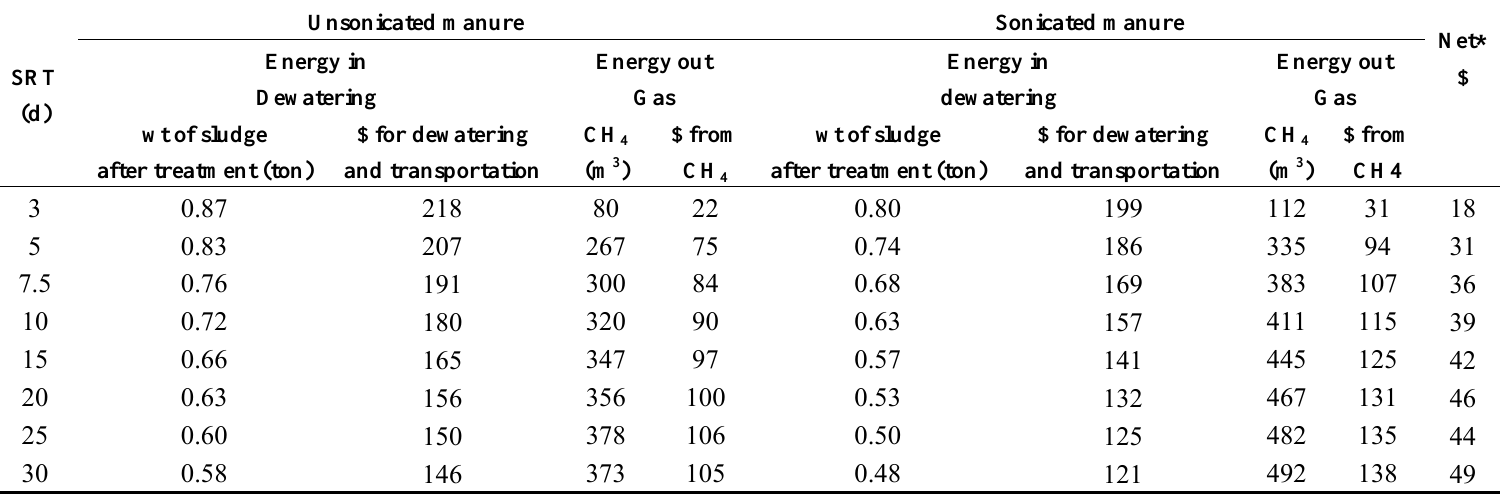
Table 4. Economical study calculation based on ton dry solids